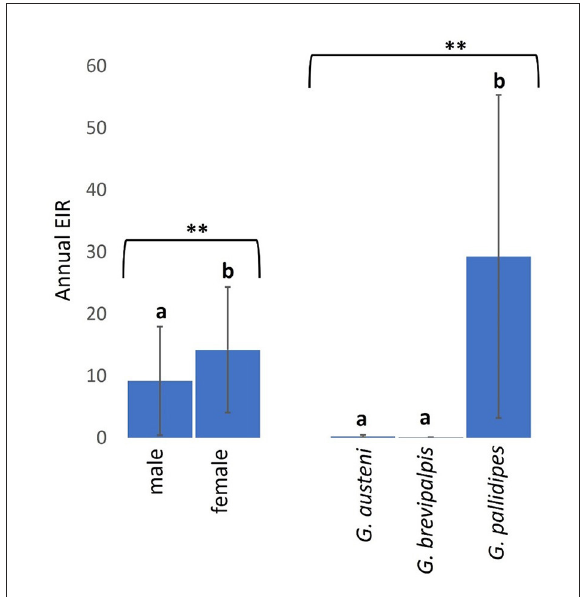
FIGURE5 Annual EIRs of tsetse flies according to fly sex and species. Error bars are used to indicate the standard error of the mean (SEM). Letters have been used to indicate presence or absence of significant difference in pairwise comparisons of tsetse fly entomological inoculation rates. Pairwise comparisons are made between tsetse flies within the same group defined by sex or species. Significantly different pairs are denoted using different letters while insignificantly different pairs are indicated using same letters. ** indicates P value <